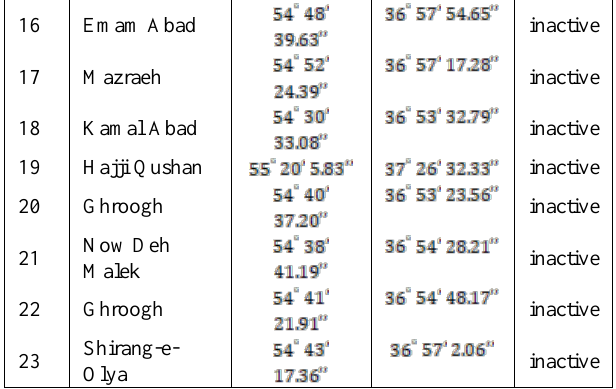
Table 1: Characteristics of Mud volcanoes in the study area (west of Golestan province) (Omrani and Raghimi, 2018). * The mud volcanoes exanimated in this study.